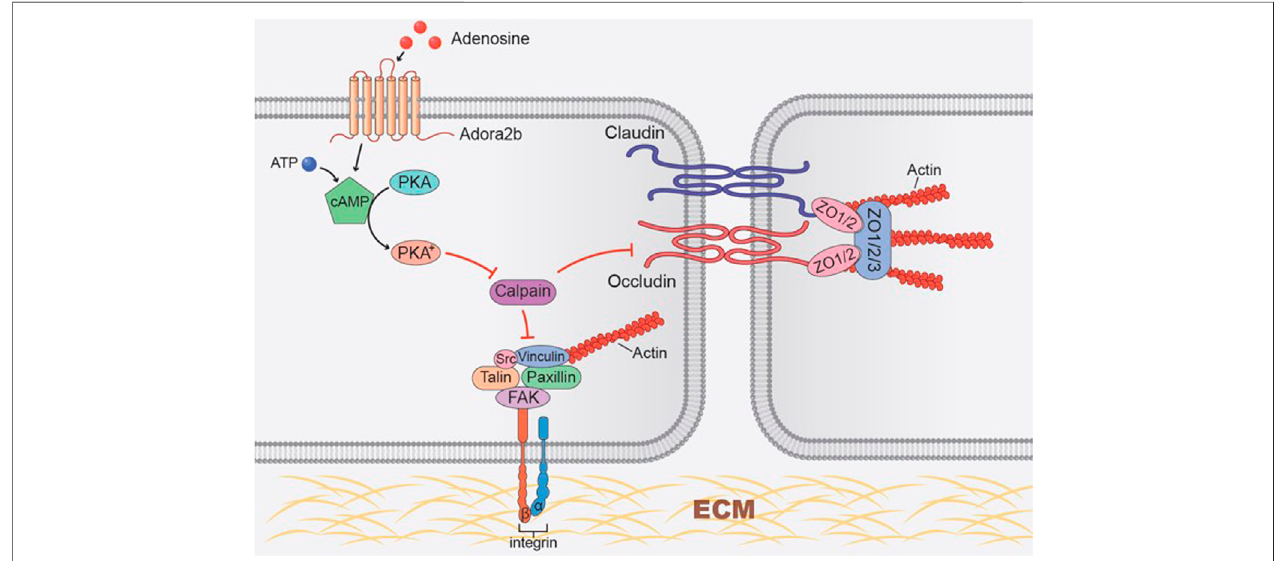
FIGURE 9 | Working model of Adora2b activation in regulating tight junction and focal adhesion junction proteins. Adora2b activation increases cAMP levels by activation of adenylyl cyclase, thus activated protein kinase A (PKA). Activated PKA then inhibits hypoxia-induced calpain activity, protects occludin and FAK degradation, and maintains the epithelial